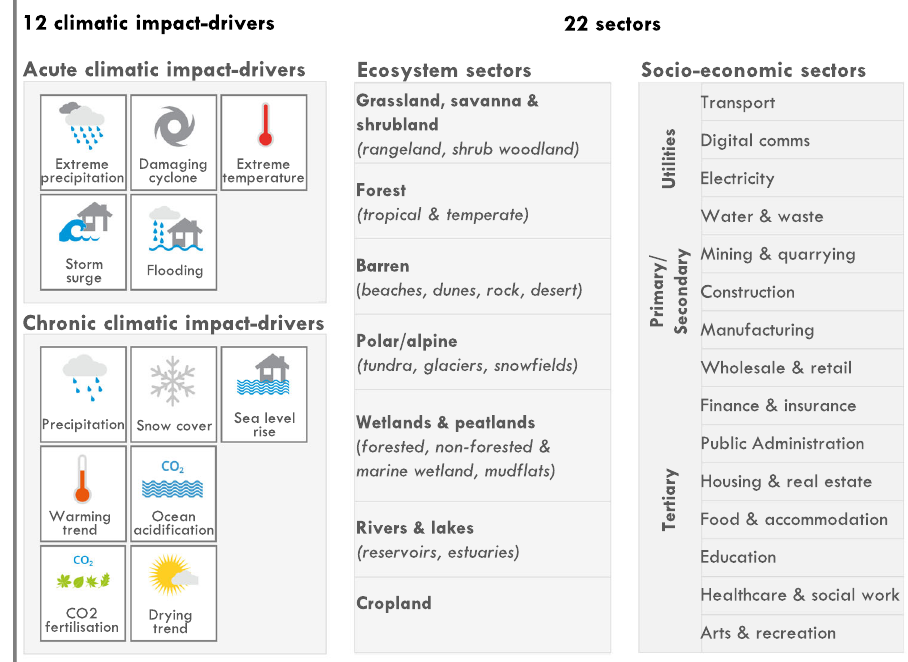
Fig. 1 Summary of climatic impact-drivers and ecosystem and socio-economic sectors considered in this paper. The sector classi fi cation is used to simplify presentation and discussion and does not represent any hierarchy of sectors. We acknowledge the grey boundaries between sectors, and have hence performed the related analysis at the service-scale, i.e. based on the services that sectors provide (see “ Methods ” ).